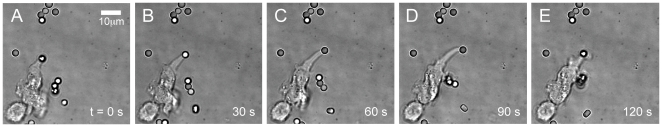
Synapse formation of Jurkat cell to trapped polystyrene bead coated with anti-CD3.(a–e) Brightfield images of Jurkat cell shows that the cell has already formed a synapse with the trapped anti-CD3 bead at 0 s. The Jurkat's protrusion actually pushes the bead out of the trap (at 30 s to 90 s) and starts to bring the bead back to the cell (at 120 s). Movie of synapse formation can be seen in Video S7.